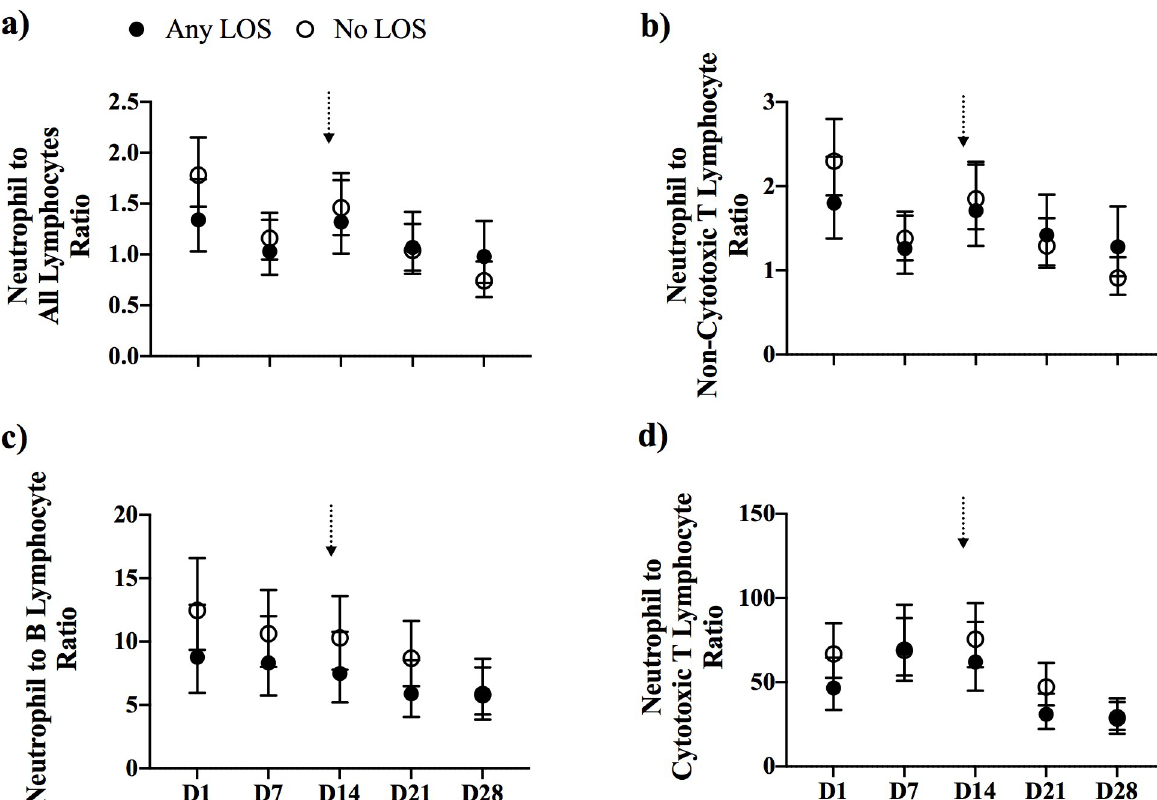
Fig 3. Neutrophil-to-lymphocyte ratios. The ratio of neutrophils to a) all lymphocytes, b) non-cytotoxic T lymphocytes, c) B lymphocytes, and d) cytotoxic T/NK lymphocytes, from preterm infants with any LOS (confirmed and clinical; closed circle) and no LOS (open circle). Analysis was performed by mixed linear regression analysis using a random effects model that was adjusted for known confounders, GA, birth weight z-score, sex and total leukocyte count. Data shown as geometric mean with 95% confidence intervals. Arrows indicate the median age of LOS onset of 13 days for infants in the any LOS